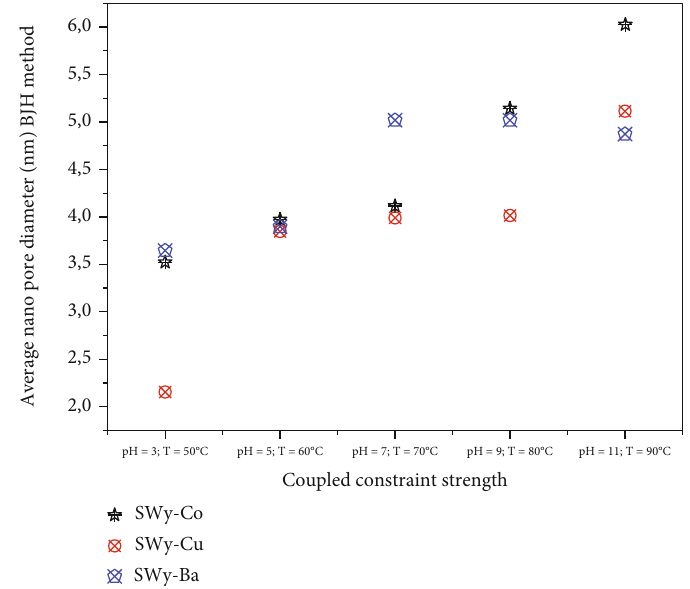
Figure 13: BJH method average pore diameter evolution versus constraint